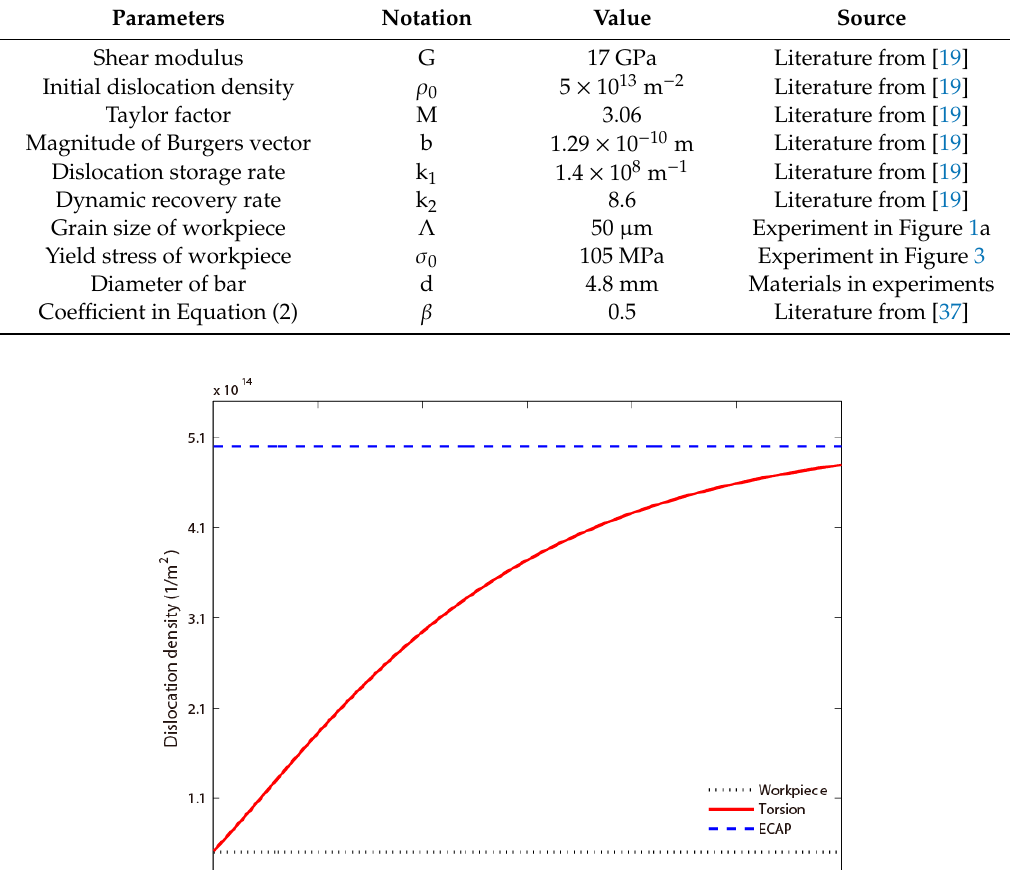
Table 2. Material parameters for AZ31B.